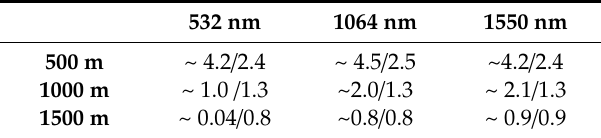
Table 8. Point density m − 2 of vegetated area in comparison to an open area (second value) at one flight line averaged over 11.3 m radii circle area (virtual plots in Figure